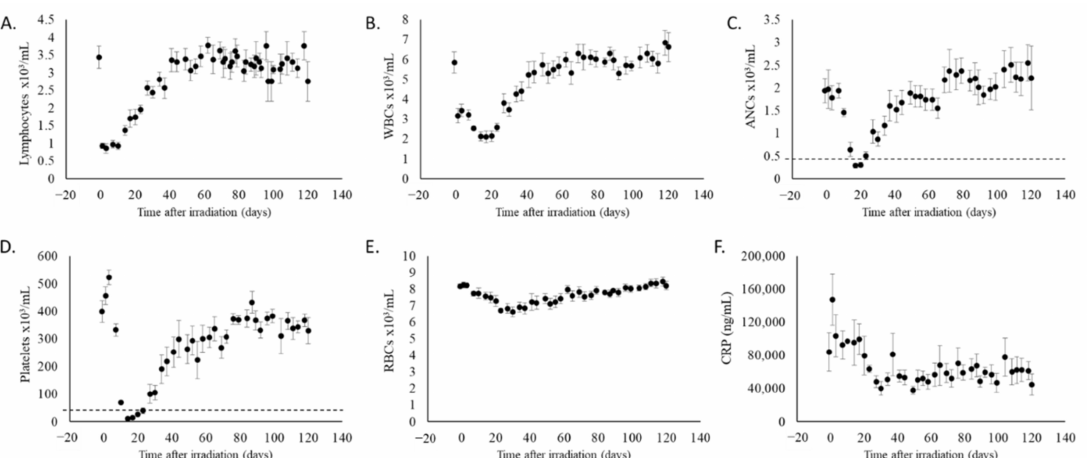
Figure 1. Evaluation of lymphocytes, white blood cells (WBCs), absolute neutrophil counts (ANCs), platelets, red blood cells (RBCs) and C-reactive protein (CRP) levels in irradiated animals. ( A ) Lymphocyte, ( B ) WBC, ( C ) ANC, ( D ) platelet, and ( E ) RBC counts were determined longitudinally in whole blood and CRP levels ( F ) were measured by ELISA in plasma collected throughout the study; values are reported as average +/ − standard error of the mean (sem). Dashed line marks the threshold of severe cytopenia (0.5 × 10 3 / µ L for neutrophils and 20 × 10 3 / µ L for platelets).